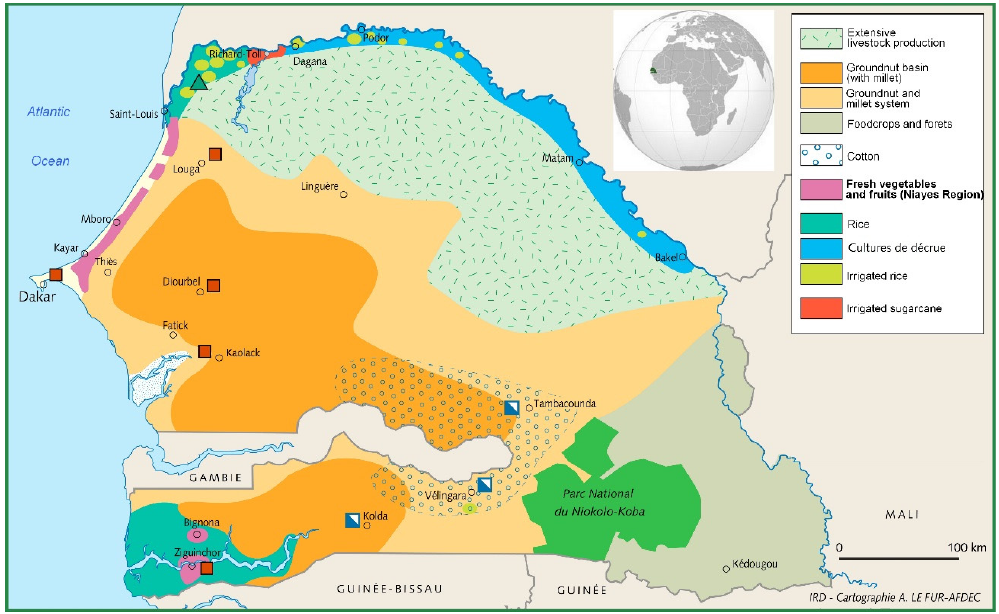
Figure 1. Location of the Niayes within the main agricultural regions of Senegal.